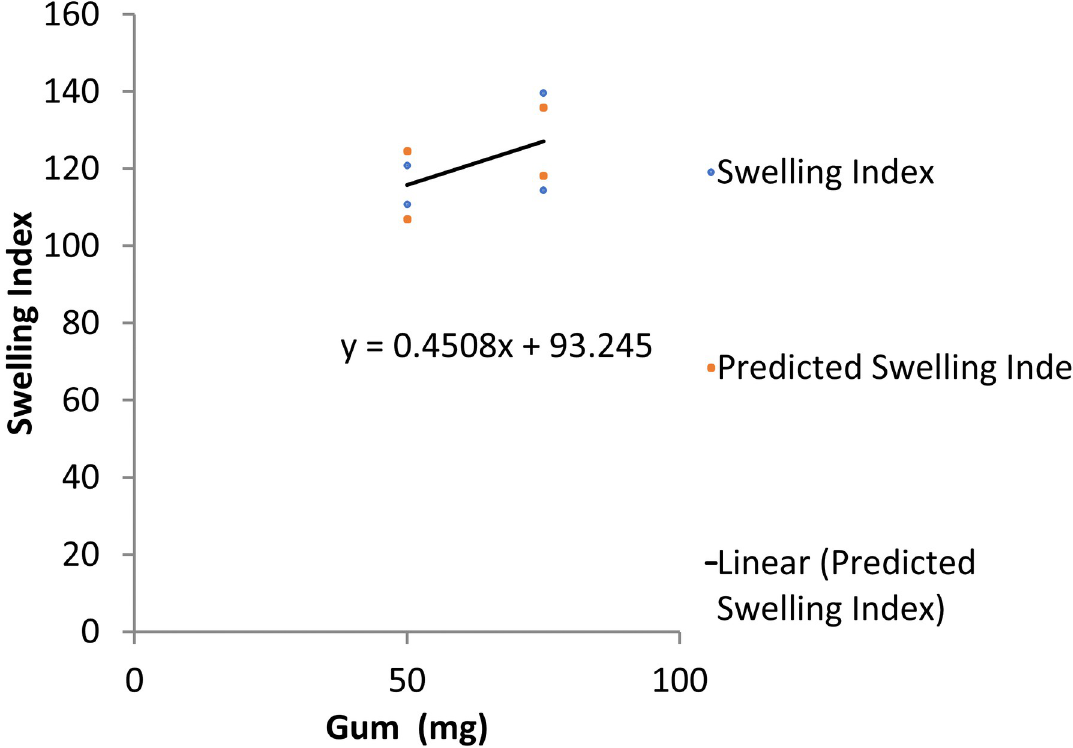
Fig 6. Line fit plot for the response of swelling index with Prunus domestica gum.